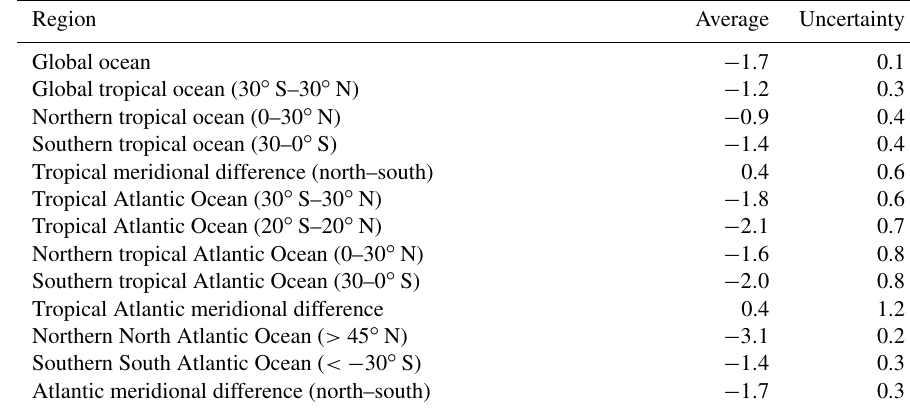
Table 2. Global and regional averages and meridional differences of NSST anomalies (LGM – modern) based on data gridded with DIVA and weighted by their